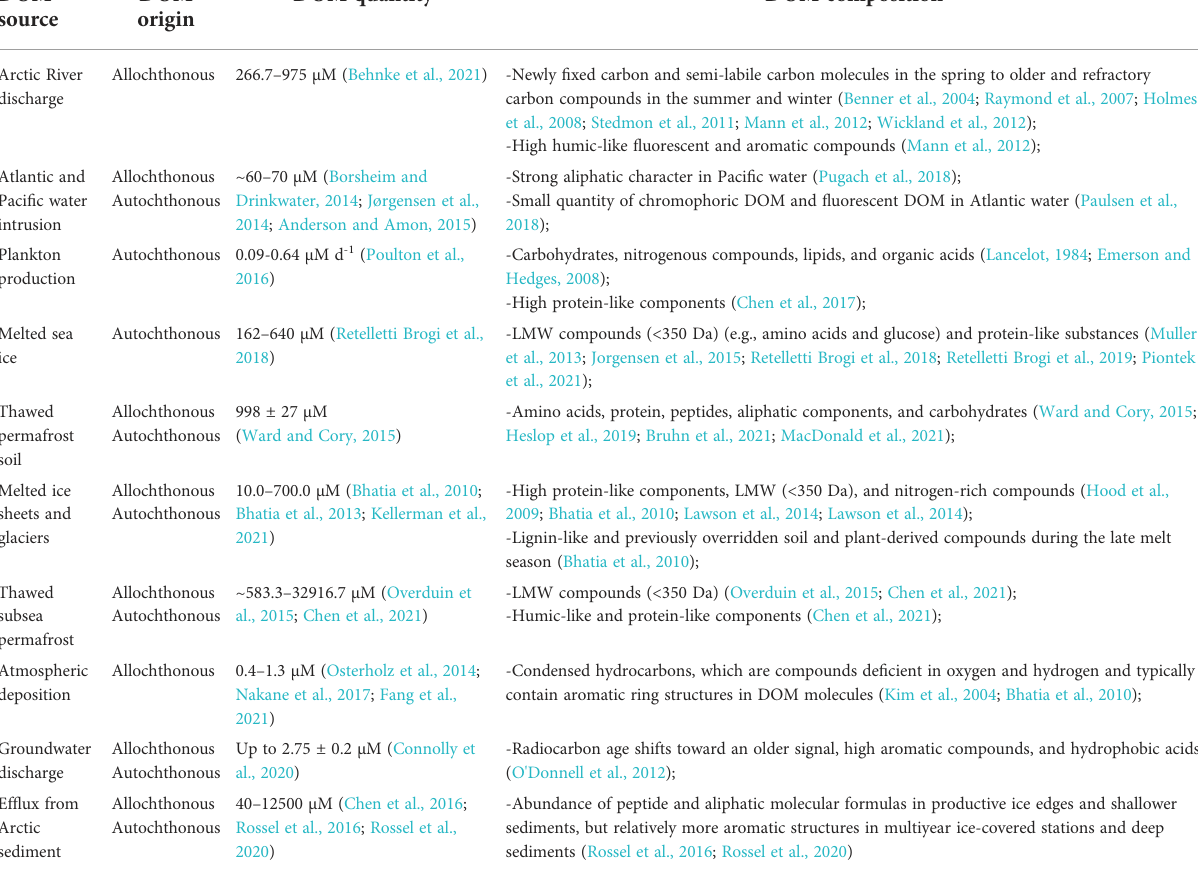
TABLE 1 Origin, concentration, and composition of DOM sources imported into the Arctic